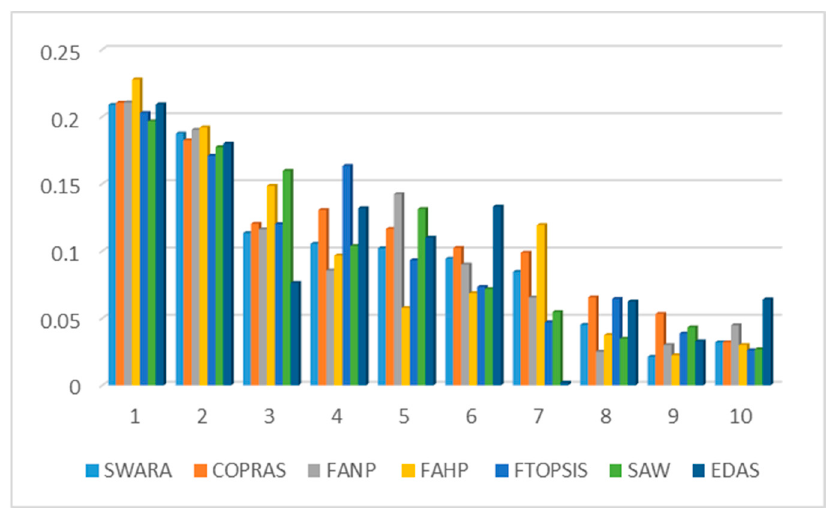
Figure 1. Graphical comparative risk ranking for the MADM methods.